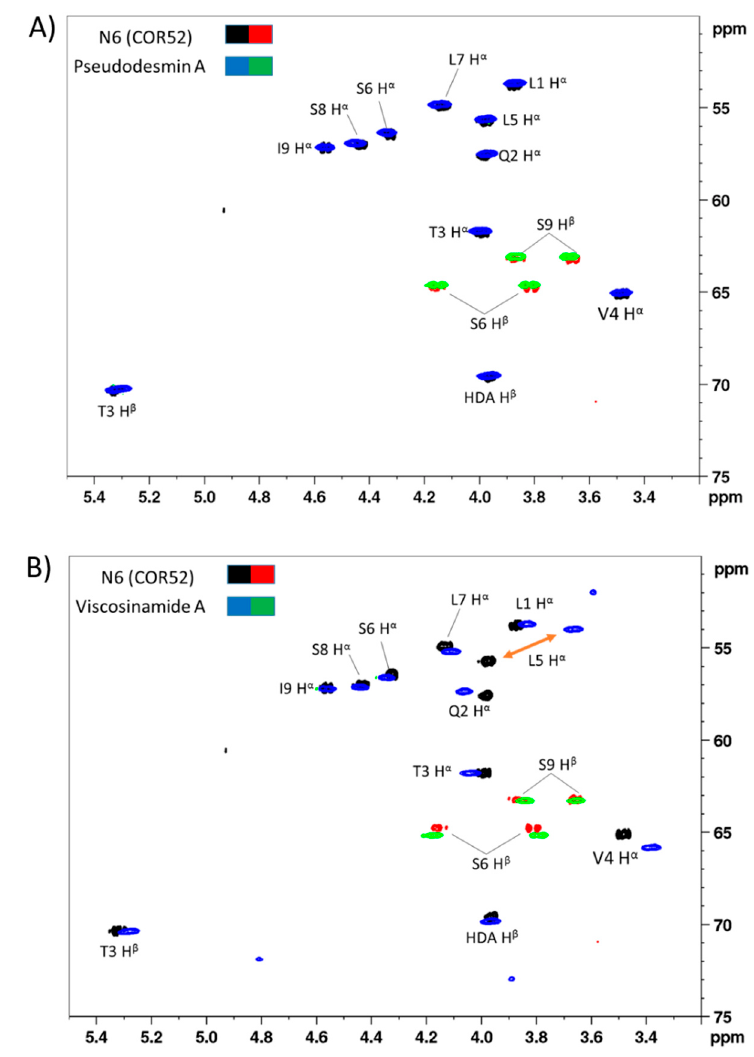
Figure A1. ( A ) Overlay of the alpha region of a 1 H- 13 C gHSQC spectrum of the isolated CLP (black/red) with that of pseudodesmin A (blue/green) recorded under identical conditions. Both spectra are undistinguishable, showing that N6 is identical to pseudodesmin A. ( B ) Overlay of the alpha region of a 1 H- 13 C gHSQC spectrum of the isolated CLP (black/red) with that of viscosinamide A (blue/green) recorded under identical conditions. A significant difference occurs for the 1 H and 13 C chemical shifts of Leu5. Likely, N6 has a different stereochemistry at this position.